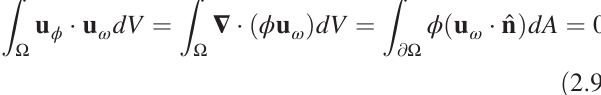
, and channel walls S out